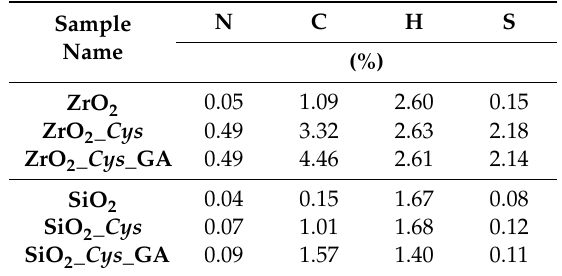
Table 2. Content of N, C, H and S in the analyzed